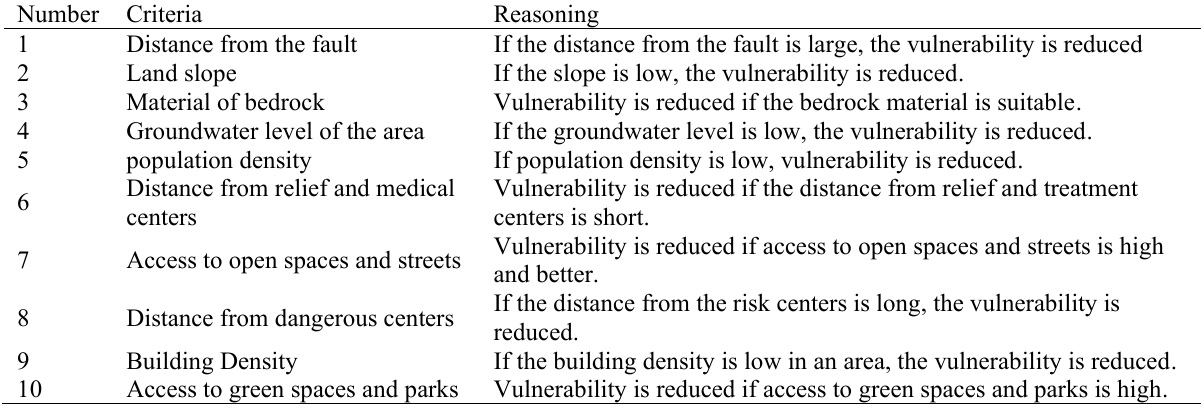
Table 1. Correlations between factors and vulnerability